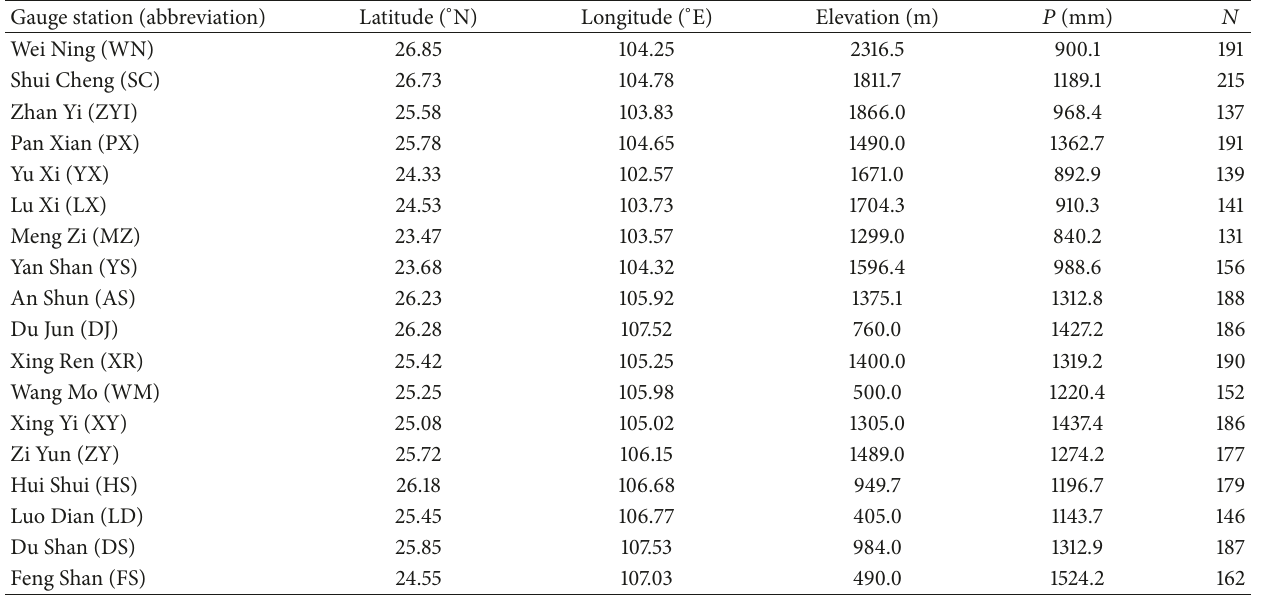
Table 1: Geographical coordinates, annual mean precipitation ( 𝑃 ), and mean number of rainy days ( 𝑁 ) (daily precipitation ≥ 0.1mm) for the selected 18 meteorological stations across the UHRB.